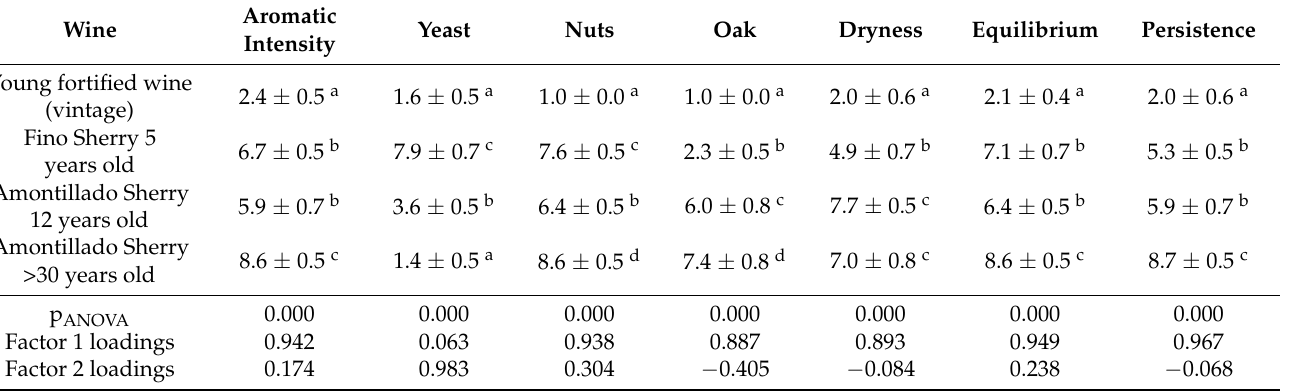
Table 14. Tasting panel scores for the different descriptors of the four wines evaluated. Values are expressed as mean ± standard deviation. The p -values resulting from the application of 1-factor analysis of variance, taking the sample as the factor of variation, are included. Different superscripts in the scores indicate significant differences among the corresponding wines. The loadings of the descriptors after factor analysis (correlation coefficients with the extracted factors) are also